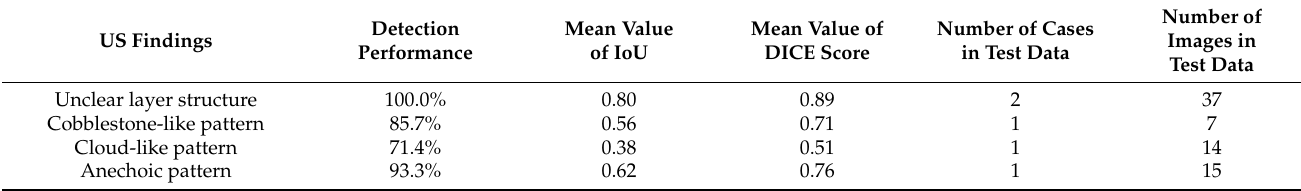
IoU: intersection over